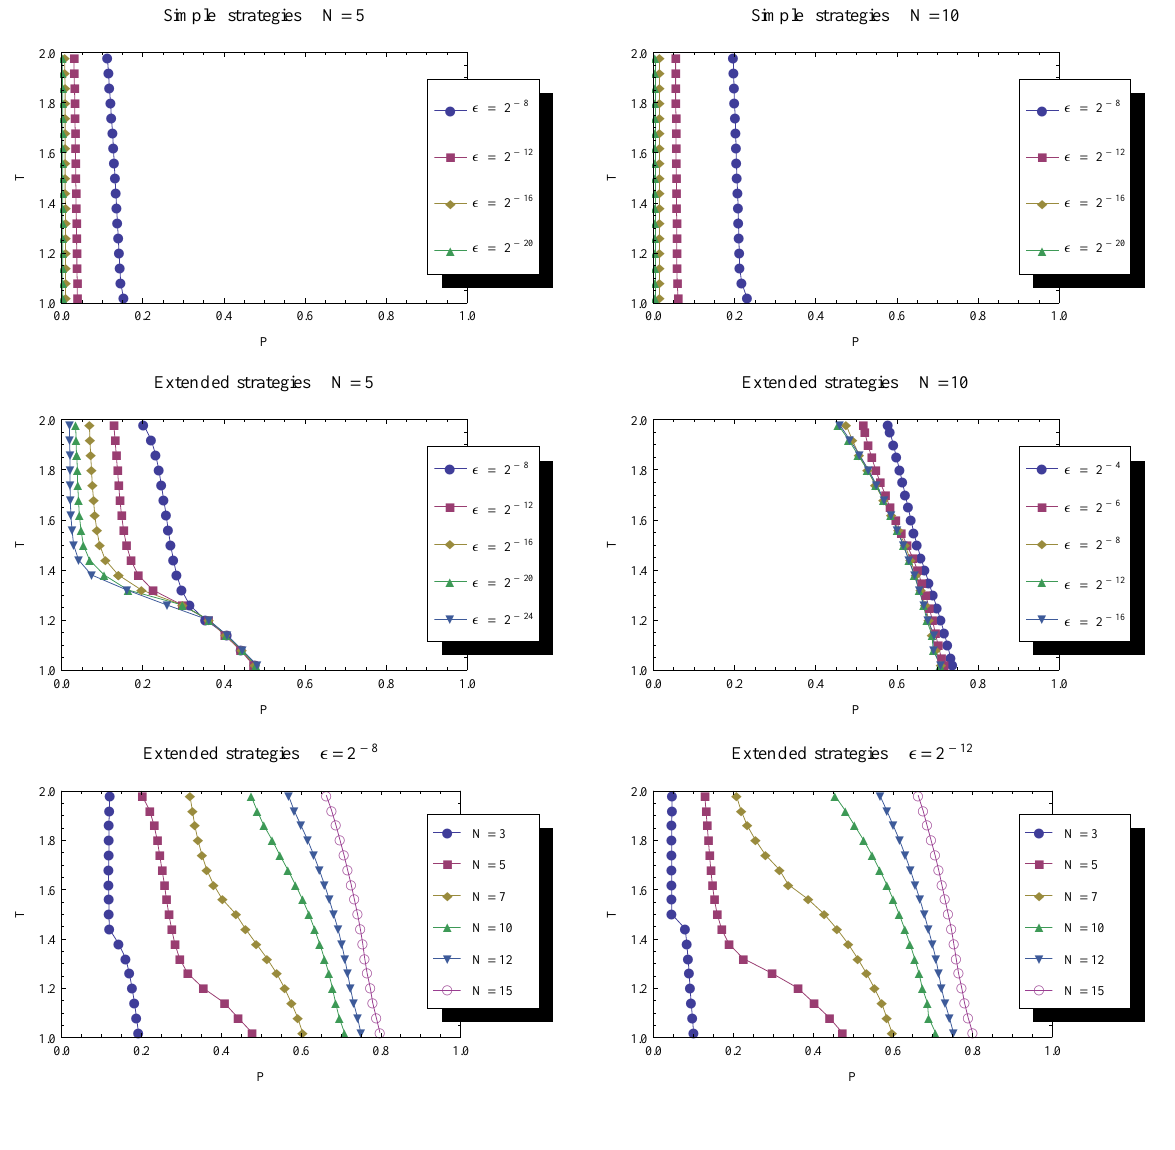
Figure 5. Parameter diagram showing which games have recurrent cooperation in the evolutionary dynamics from a starting point of initial cooperation. Top row: simple strategy set. Middle row: extended strategy set with Convincers and Followers. In the graphs, recurrent cooperation exists to the left of the line and a fixed point with defectors characterizes the behaviour to the right. For simple strategies, lowering (cid:15) steadily reduces the part of parameter space dominated by recurrent cooperation. In the bottom row, the delimiting line is shown for a variety of game lengths and for two levels of mutation (left and right), illustrating the fact that the longer the game the larger the parameter region supporting cooperative phases in the evolutionary